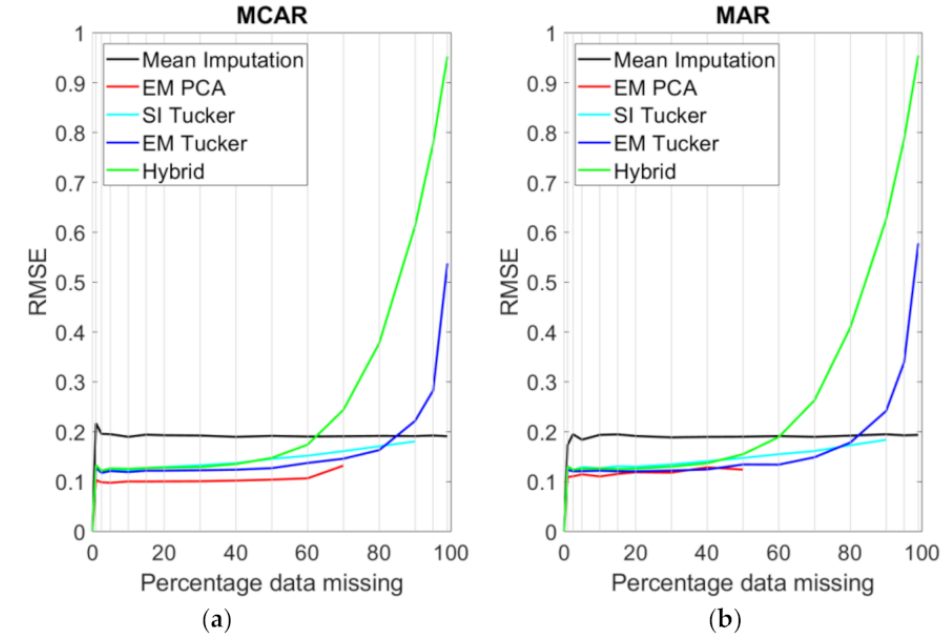
Figure 9. RRMSE for different models using the noisy tensor, SIM2, with artificially added MCAR ( a ) and MAR ( b )